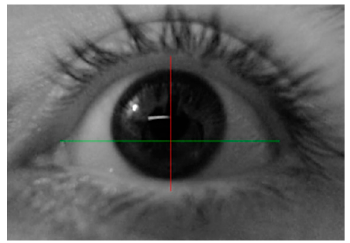
Figure 9. Eye tracking region variable.